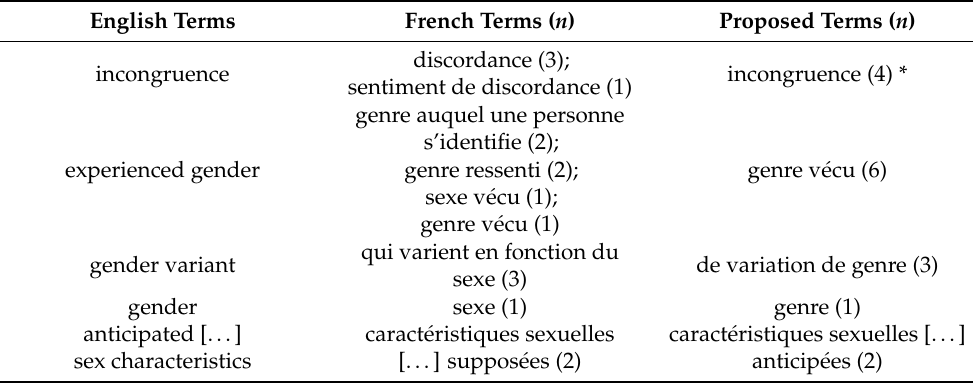
Table 3. Discrepancies between